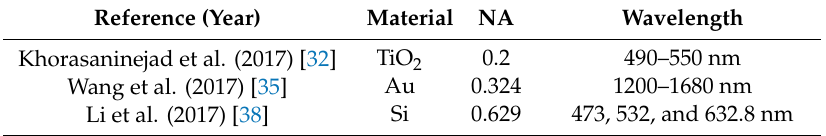
Table 2. Comparison of metasurface-based lens in broadband achromatic optics design.